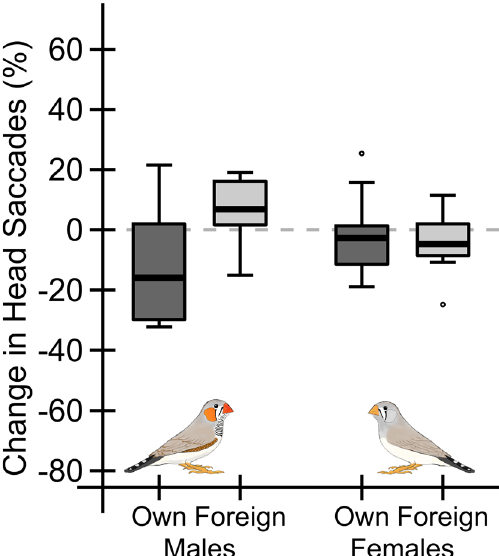
Figure 2. Male and female behavioural reaction, i.e. head saccade change, in response to the different odour stimuli. Shown is the change in head saccades, i.e. the difference in head saccades after odour presentation and before odour presentation. Negative values indicate a decrease in the number of head saccades, whereas positive values indicate an increase. We found a significant interaction of stimulus type and parental sex. Moreover, we found a significant difference in head movements between males receiving the own chick odour and males receiving the foreign chick odour, but not in